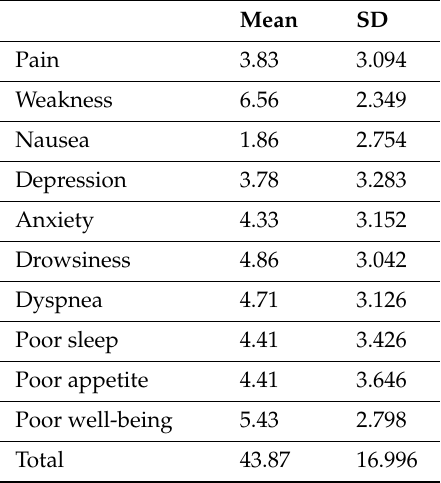
Table 2. Mean intensity (SD = standard deviation) of ESAS